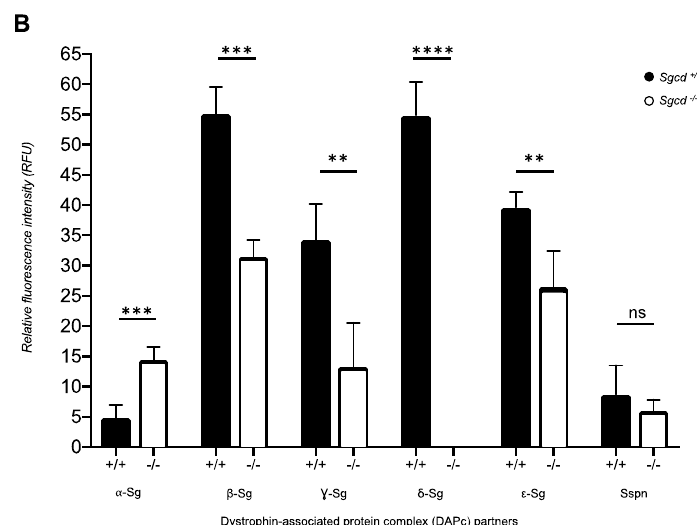
Figure 2. Indirect immunofluorescence against the sarcoglycan–sarcospan protein complex in retinal sections of three-month-old Sgcd − / − ( n = 3) and Sgcd +/+ ( n = 3) mice. ( A ) Representative images were taken at 20 × 3.63 magnification by confocal microscopy. Sg: sarcoglycan; Sspn: sarcospan; Neg. ctrl: negative control; PR: photoreceptor layer; ONL: outer nuclear layer; OPL: outer plexiform layer; INL: inner nuclear layer; IPL: inner plexiform layer; GCL: ganglion cell layer; ns: not significant at the 0.05 level. Scale bar: 50 µm. ( B ) Immunofluorescence intensities quantifications, means ± standard error. Overall significance from an ANOVA and pairwise comparison by Student’s t -test with